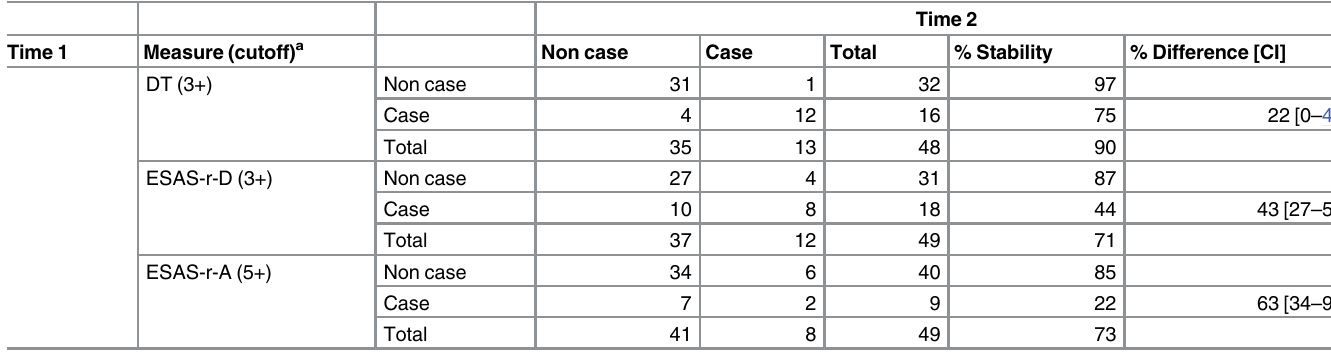
Table 3. Stability of Test Measures Using Cutoffs. Time